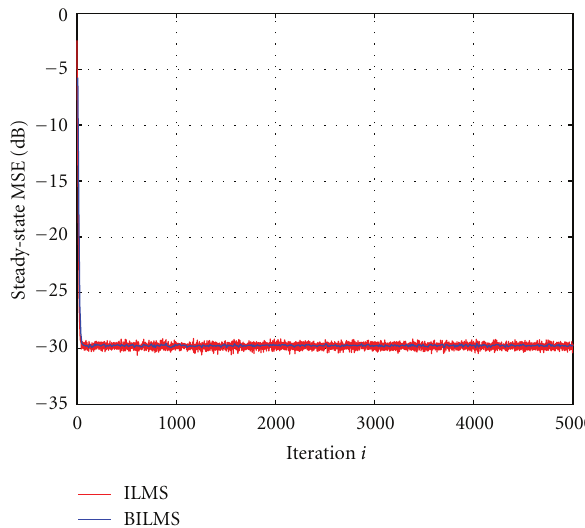
Figure 10: Global mean-square deviation (MSD) curve for incre- mental LMS and block incremental LMS.